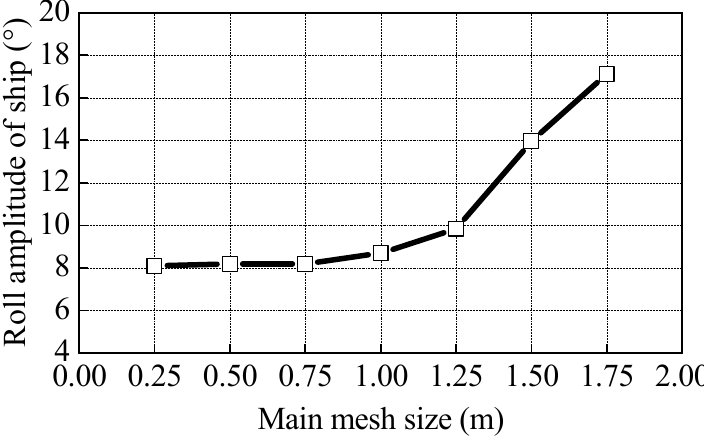
Figure 6. Mesh convergence analysis. In addition, the roll motion numerical results of the ship simulation model without the gyrostabilizer were compared with the sea trial data of the actual ship under the same working conditions. When the significant wave height h 1/3 was 1.5 m and the period T was 4.0 s, the time-series roll motion of the actual ship roll motion and beam waves are shown in Figures 7 and 8 respectively.